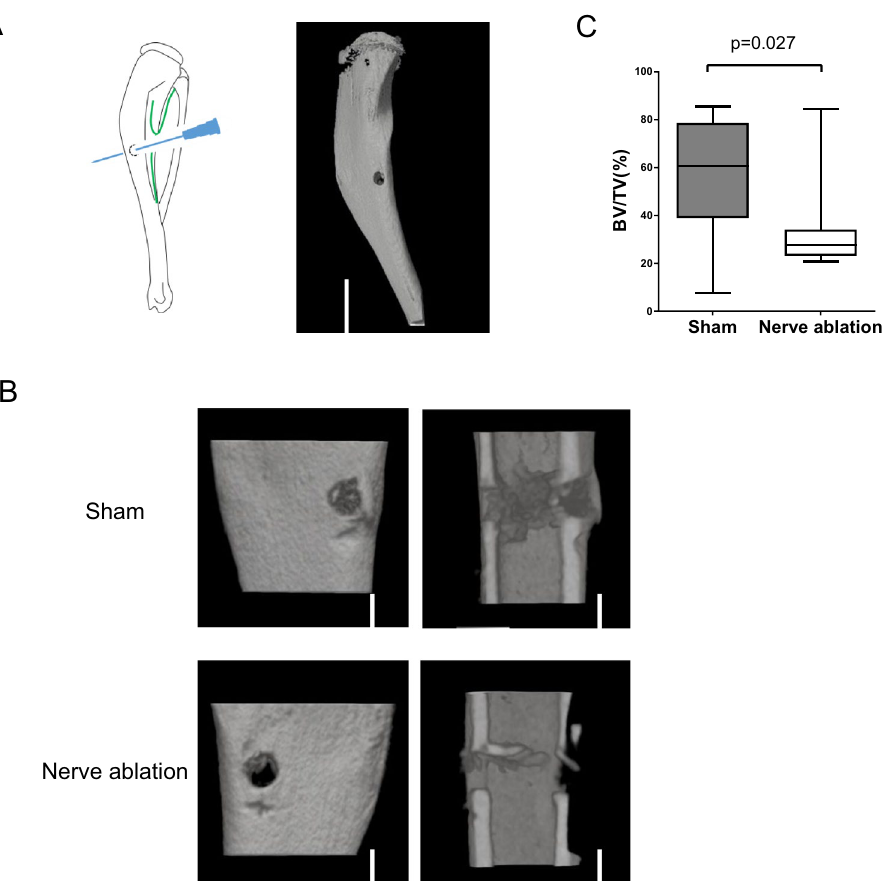
Figure 4. Surgical nerve ablation also suppresses bone regeneration. ( A ) Schematic diagram of the procedure used to create the drill hole model (left panel). A micro-CT image captured after the creation of drill holes (right panel). Scale bar: 3000 µm. ( B ) Micro-CT 3D reconstruction images and coronal planes of the drilling site in the sham operation group and nerve ablation group, showing impaired bone regeneration in the nerve ablation group. Scale bars: 600 µm. ( C ) Micro-CT analysis of the regenerated cortical bone mass at the drilling site. All data are presented as the means ± SEMs (n = 4). P values were obtained using a two-tailed paired t test ( C